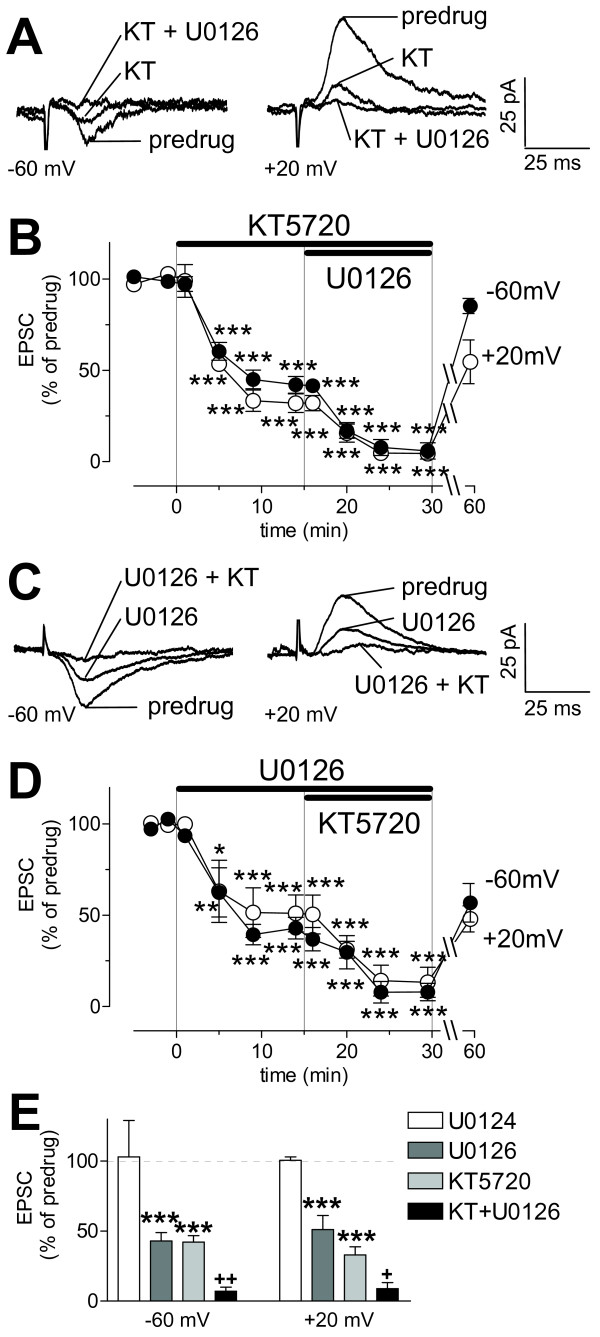
Additive effect of PKA and ERK inhibitors on NMDA receptor-mediated synaptic plasticity. (A, B) KT5720 (KT, 1 μM, 15 min; n = 3) inhibited the pharmacologically (with NBQX, 20 μM; bicuculline, 30 μM) isolated NMDA receptor-mediated synaptic component in slices from arthritic rats (P < 0.001, repeated-measures ANOVA with Bonferroni post-tests). Co-application of KT5720 and U0126 (1 μM, n = 3) further decreased the synaptic response (P < 0.001, Bonferroni post-tests). (C, D) U0126 (1 μM, 15 min) applied alone (n = 3) or together with KT5720 (n = 3) inhibited the NMDA component in the arthritis pain model (P < 0.05–0.001, Bonferroni post-tests). (E) Coapplication of KT5720 and U0126 (n = 6) had a significantly greater effect than each compound alone (P < 0.05–0.01, one-way ANOVA with Bonferroni post-tests). A negative structural analogue of U0126 (U0124, 1 μM, n = 3) had no effect. Bar histograms show averaged EPSC amplitudes (mean ± SE) normalized to predrug control values (set to 100%). (A, C) Monosynaptic EPSCs (average of 8–10 traces) recorded at -60 mV and +20 mV. (B, D) Time course of drug effects at -60 mV and +20 mV. Each symbol shows averaged EPSC amplitudes (mean ± SE) normalized to predrug control (set to 100%). * P < 0.05, ** P < 0.01, *** P < 0.001 (compared to predrug values); + P < 0.05, ++ P < 0.01 (compared to each drug alone).